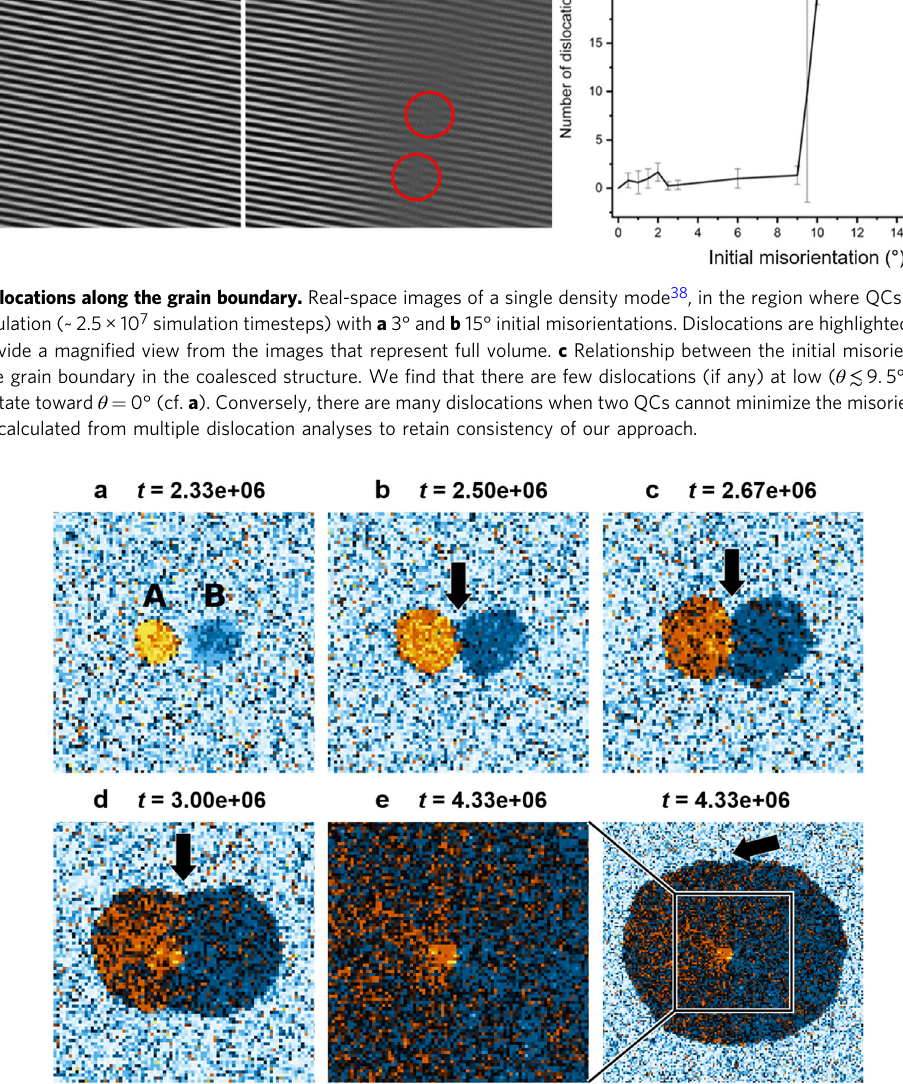
Fig. 5 Growth of a single d-QC from two seeds. Seeds are labeled A and B in a with 6° misorientation. Here, coarse-grained images of the aperiodic {00001} plane show the local grain orientations (LGO) of d-QC grains a during early stages of grain growth; b immediately after collision; c after collision, grain rotation to minimize grain misorientation; d early stages of grain coalescence; e after grain coalescence. All heatmaps are cropped according to e from the total volume. Subplots a – e are colored on the basis of an expected particle seed distribution, as shown in the middle column of Fig. 3. Contiguous regions of white in subplots a – e correspond to liquid regions. Arrows in b and c point to the GB grooves at the QC-liquid interfaces. Arrows in d and e point to regions where the GB groove has fl grain rotation rates as a function of initial grain misorientation (Supplementary Fig. 6) show strong and qualitative agreement with classical equations for the dependence of GB free energy ( γ gb ) on misorientation ( θ ) 41 and driving pressure of sliding, γ R denotes grain radius 18 . The presence of 1 gb P k (cid:3) (cid:1) d R , where d θ sliding and the gradual disappearance of the GB groove in Fig. 5